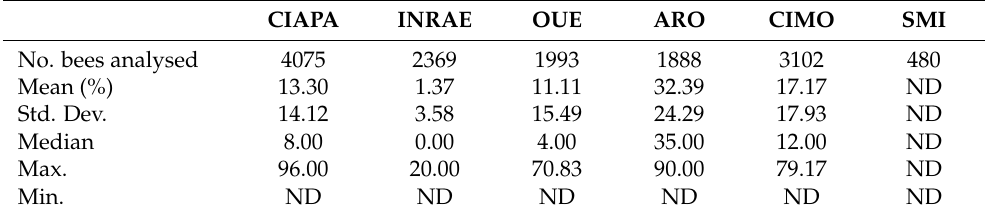
Table 3. Intra-colony prevalence at each apiary. Percentage of N. ceranae infected honey bees per colony during the study. ND: Not detected